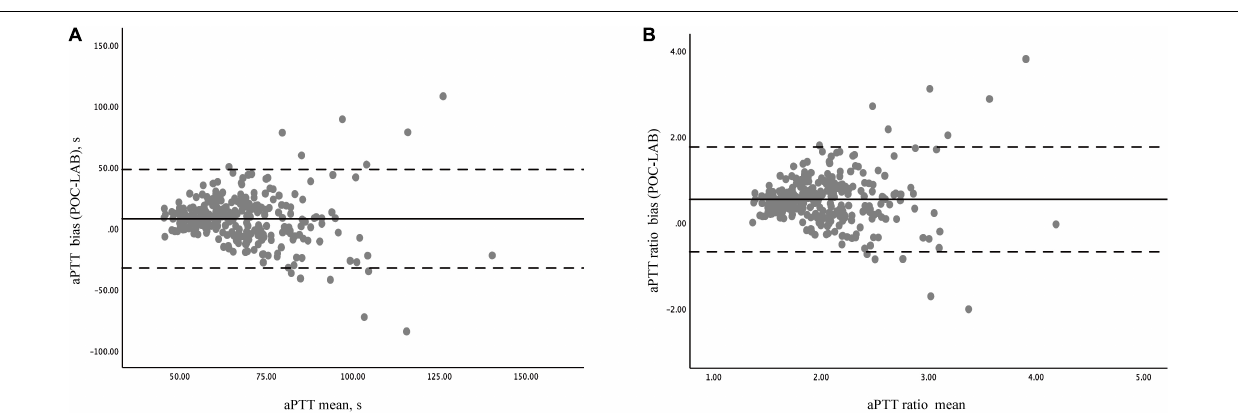
FIGURE 3 | Bland –Altman diagram of the difference and agreement between POC-aPTT and LAB-aPTT. (A) The total bias between POC-aPTT and LAB-aPTT value. POC-LAB: POC-aPTT value—LAB-aPTT value, aPTT mean: 1/2 × (POC-aPTT value + LAB-aPTT value). (B) The total bias between POC-aPTT and LAB-aPTT ratio. POC-LAB ratio: POC-aPTT ratio to the normal value—LAB-aPTT ratio to the normal value, aPTT ratio mean: 1/2 × (POC-aPTT ratio to the normal value + LAB-aPTT ratio to the normal value). The bias representatives the systematic error between the two judgments (bold line), the mean difference ± 1.96 standard deviations represents the limit of agreement or the 95% confidence interval (dotted